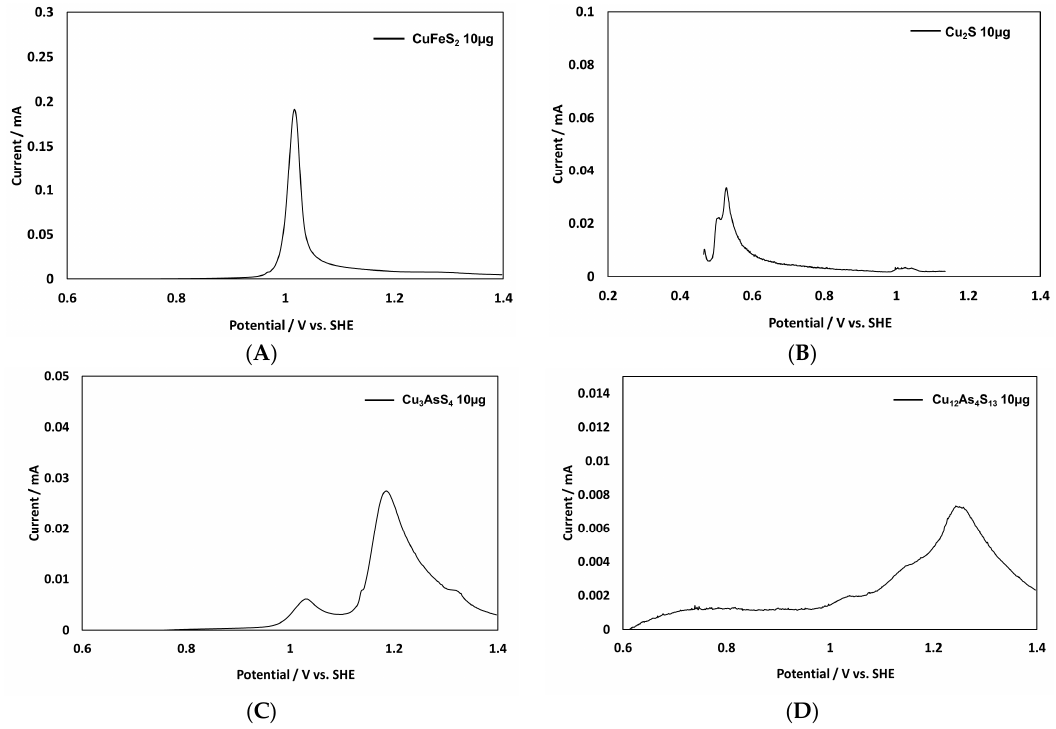
Figure 5. Comparison between voltammograms on various sulfide mineral: result of potential polarization with 10 µg of chalcopyrite ( A ) and chalcocite ( B ); result of potential polarization with 10 µg of enargite ( C ) and tennantite ( D ).